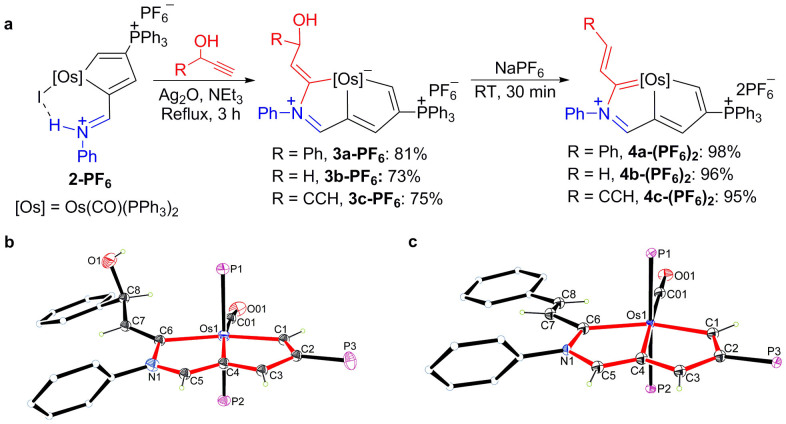
Synthesis of aza-osmapentalene 4-(PF6)2.(a) The reaction of osmacyclopentadiene 2-PF6 with substituted propynols followed by dehydroxylation produces aza-osmapentalene 4-(PF6)2. (b, c) X-ray structures of 3a-PF6 (b) and 4a-(PF6)2 (c) (50% probability level). Phenyl moieties in PPh3, the counter anion and the solvent molecules have been omitted for clarity. Selected bond lengths (Å) for 3a-PF6: Os1-C1 2.040(8), Os1-C4 2.100(7), Os1-C6 2.180(9), C1-C2 1.381(11), C2-C3 1.450(11), C3-C4 1.373(12), C4-C5 1.377(13), C5-N1 1.313(11), C6-N1 1.483(11), C6-C7 1.338(12), C7-C8 1.489(12), C8-O1 1.430(12). Selected bond lengths (Å) for 4a-(PF6)2: Os1-C1 2.041(4), Os1-C4 2.069(4), Os1-C6 2.082(4), C1-C2 1.407(5), C2-C3 1.410(5), C3-C4 1.394(5), C4-C5 1.381(5), C5-N1 1.374(5), C6-N1 1.396(5), C6-C7 1.465(5), C7-C8 1.337(5).